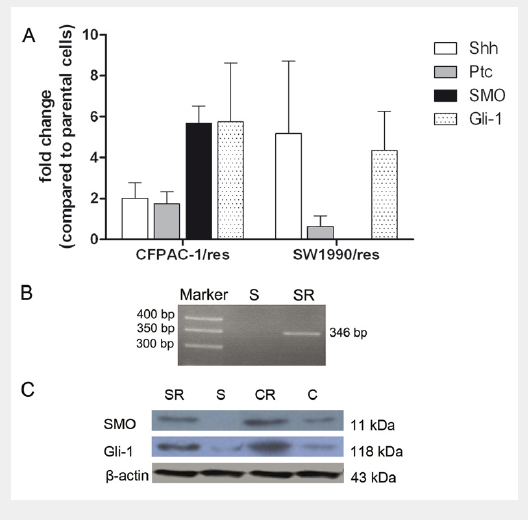
Gemcitabine-resistant pancreatic cell lines highly express hedgehog members. A, Quantitative RT-PCR was used to evaluate the relative expression level of Shh, Ptc, SMO, and Gli-1 in gemcitabine-resistant cells in comparison to their parental cells. Fold change was analyzed using the 2 –ΔΔCt method, while the expression of β-actin was used to normalise the relative expression of each gene within each cell line. Values represent mean ± S.D. of three independent experiments. B, mRNA expression of SMO can be detected in SW1990/res cells but not parental cells. C, The different protein expression levels of SMO and Gli-1 are consistent with mRNA